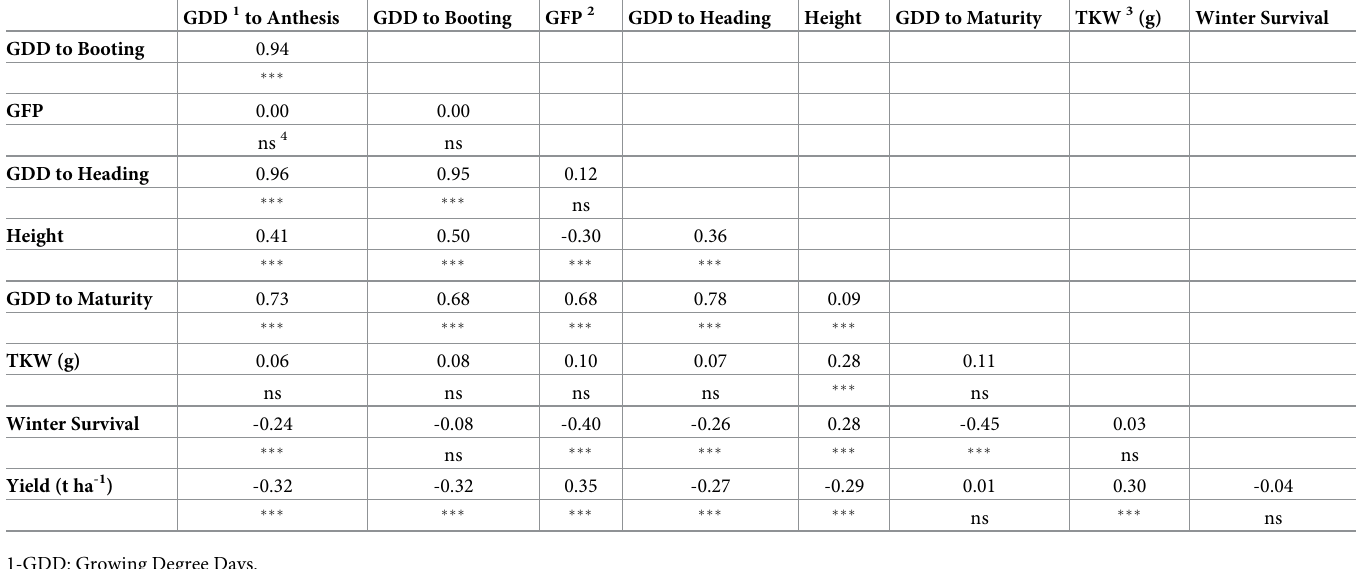
Table 4. Pearson’s coefficient of correlations (above) and their significance probability (below) for pair-wise phenotypic traits observed in 2015 and 2016 field trials in Elora and Woodstock locations. GDD 1 to Anthesis GDD to Booting GFP